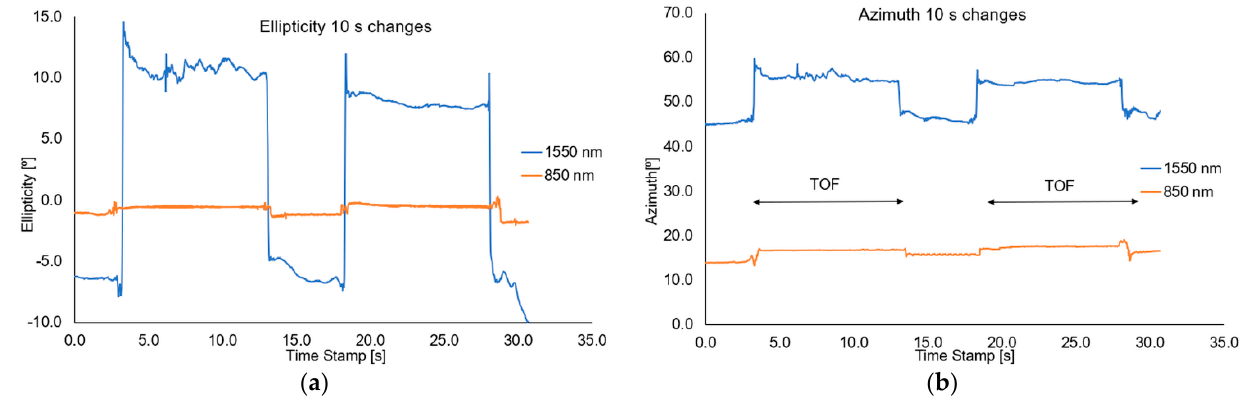
Figure 17. Graphs of influence of shifting the magnetic mixture on the change of ellipticity ( a ) and azimuth ( b ) for 5s reaction of magnetic field for wavelengths of 850 nm and 1550 nm.